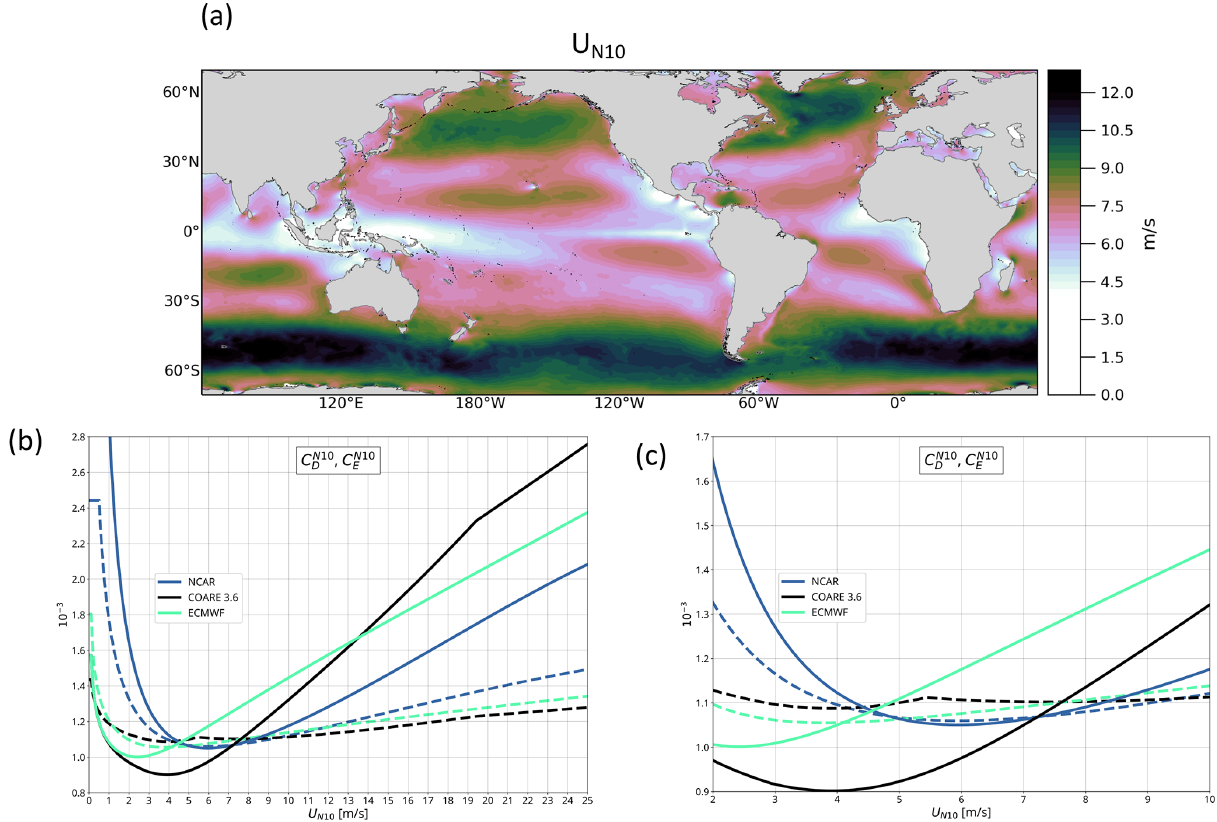
Figure 1. (a) Annual mean U N10 from NCAR parameterization. (b) Neutral drag and moisture transfer coefficients ( C N10 COARE (black), NCAR (blue), and ECMWF (green) bulk parameterizations (solid and dashed lines, respectively) as functions of the neutral wind speed at 10m. (c) Zoom of panel (b) for the wind range 2–10ms − 1 .